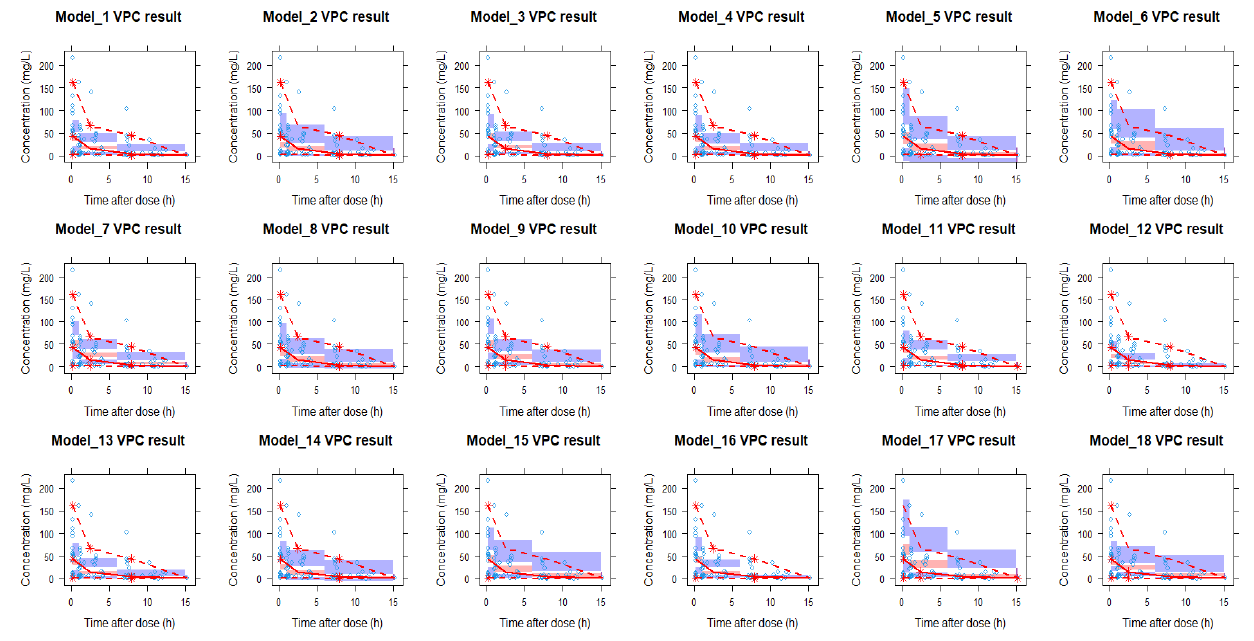
Figure 1. Observed meropenem concentration–time data and the visual predictive check (VPC) of the 18 models. The blue brackets are the observed concentrations. The red line is the observed median and the two blue lines are the 5th and 95th percentiles of the observed data. The red shaded area is the 95% CI of the model predicted median and the purple shaded areas are the 95% CIs of the model-predicted 5th and 95th percentiles. Red lines above the shaded areas represents model underprediction and red lines under the respective areas represents overprediction of the models at those intervals Additionally, VPCs were stratified (Figure S1) on whether patients received renal replacement therapy or not (RRT versus non-RRT). Overall, the observed concentrations in the non- RRT group were lower than in the RRT group. In the non-RRT group, the median peak concentrations (at time after infusion 0–1 h) were underestimated for six models (model 2, 8, 10, 11, 12, 14, 18) and overestimated for three models (models 7, 9 and 17). Median trough concentrations (time after 6–15